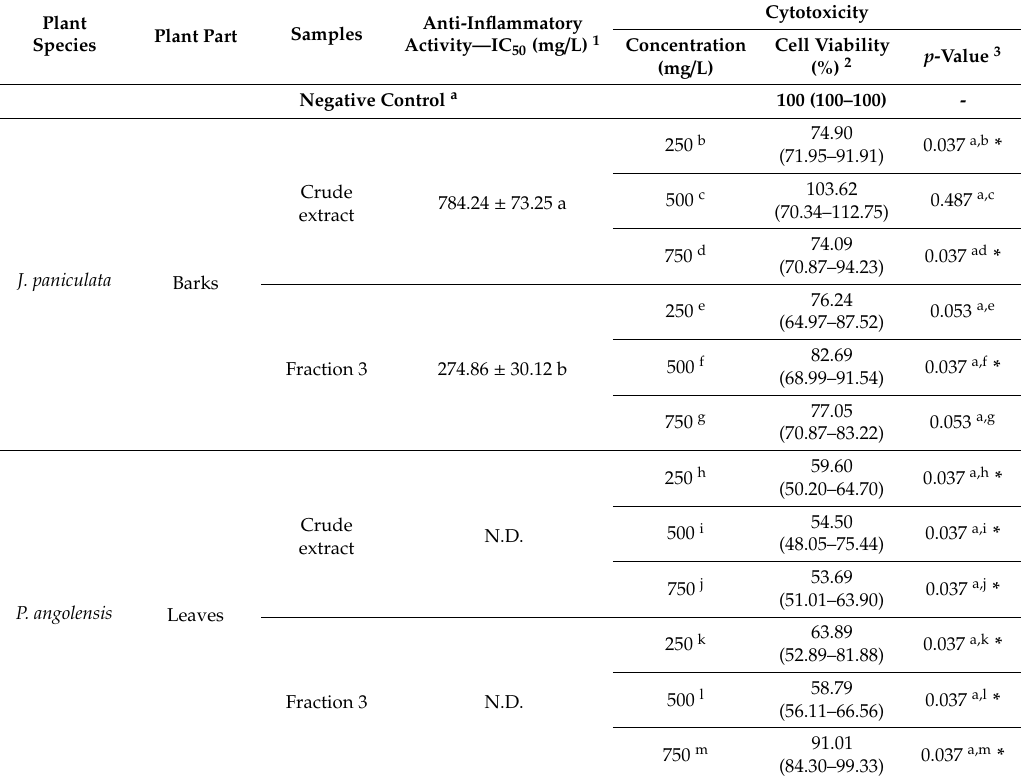
Table 7. Anti-inflammatory and cytotoxicity